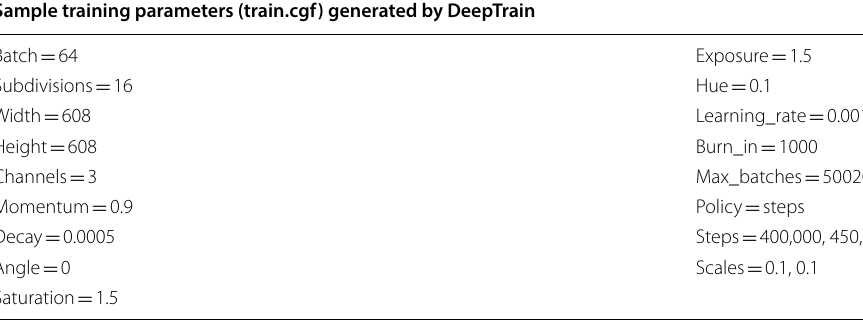
Table 6 Training parameters generated by DeepTrain model Sample training parameters (train.cgf) generated by DeepTrain